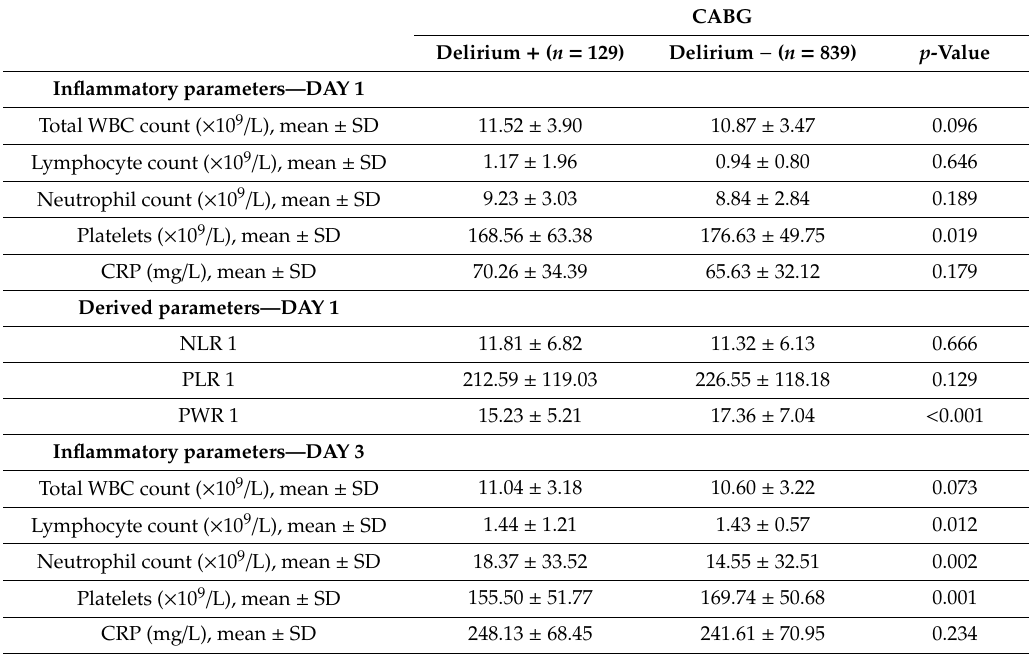
Table 5. Mean levels of post-operative inflammatory markers and derived parameters for patients with and without POD after CABG. POD, Postoperative delirium; CABG, coronary artery bypass grafting.